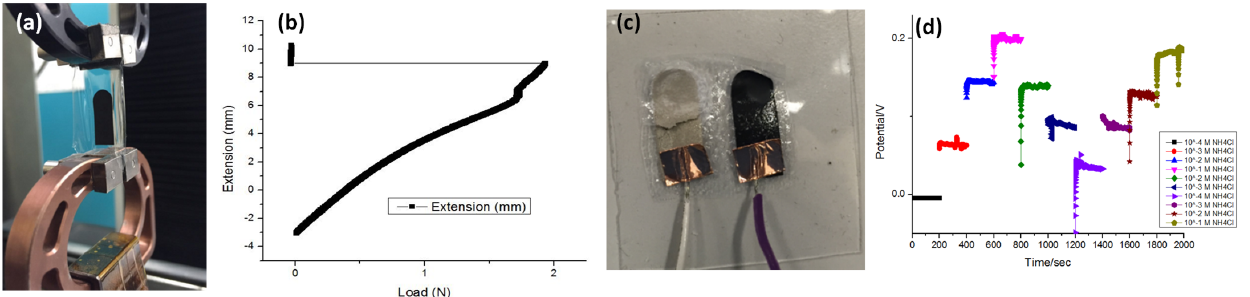
extension-load curve of the sweat sensor; ( c ) The poor adhesion between the electrodes and the PDMS substrate after the tensile test; ( d ) Potentiometric output of the sensor with the PDMS substrate after the tensile test.